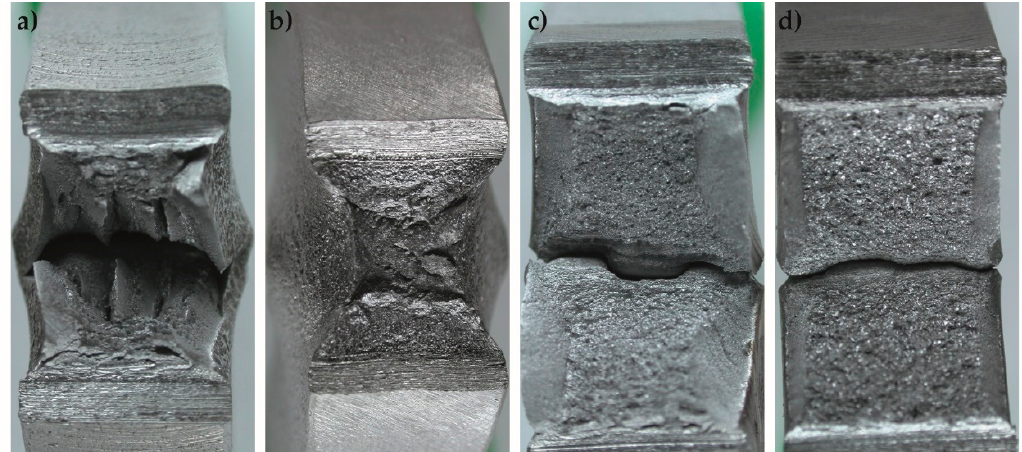
Figure 15. Fracture surfaces of samples after the Charpy impact test for following samples: ( a ) BMCH_02; ( b ) VFCH_FD_01; ( c ) GCH_FD_02; and ( d ) GCH_D0_02.